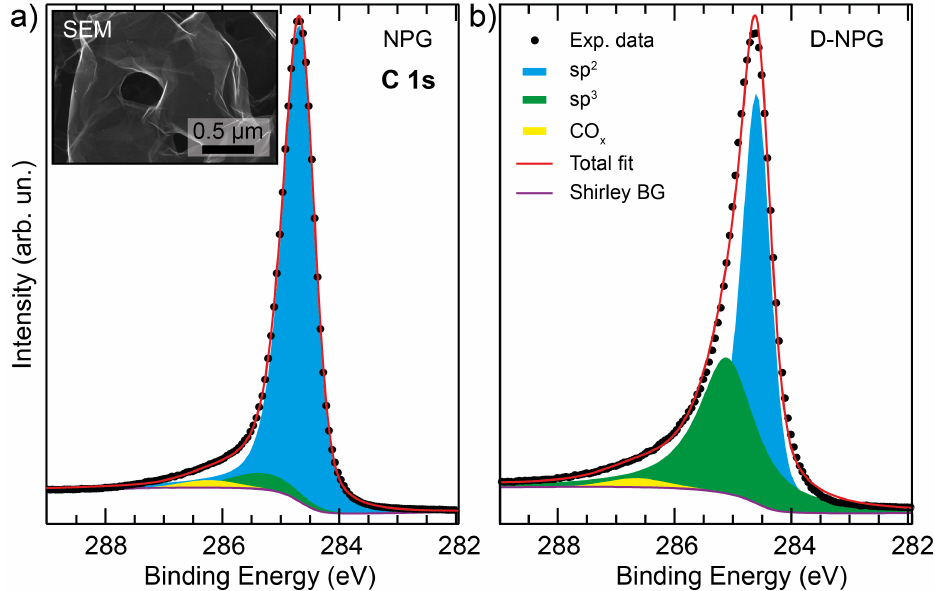
Figure 2. C 1s core level XPS spectra and fitting curves for clean pristine NPG ( a ) and deuterated-NPG ( b ); experimental data (black dots), sp 2 fitting component (blue areas), sp 3 component (green areas), CO x component (yellow areas), Shirley background (violet lines), and fitting sum curve (red lines). An SEM image of NPG is reported in the inset to panel ( a